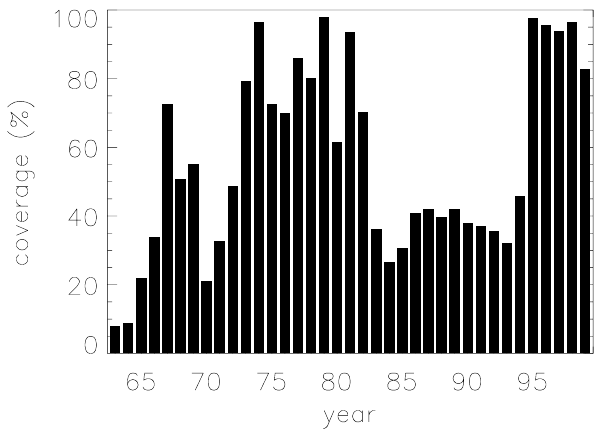
Fig. 1. Data coverage of solar wind density observations for OMNI data between 1963 and 1999.